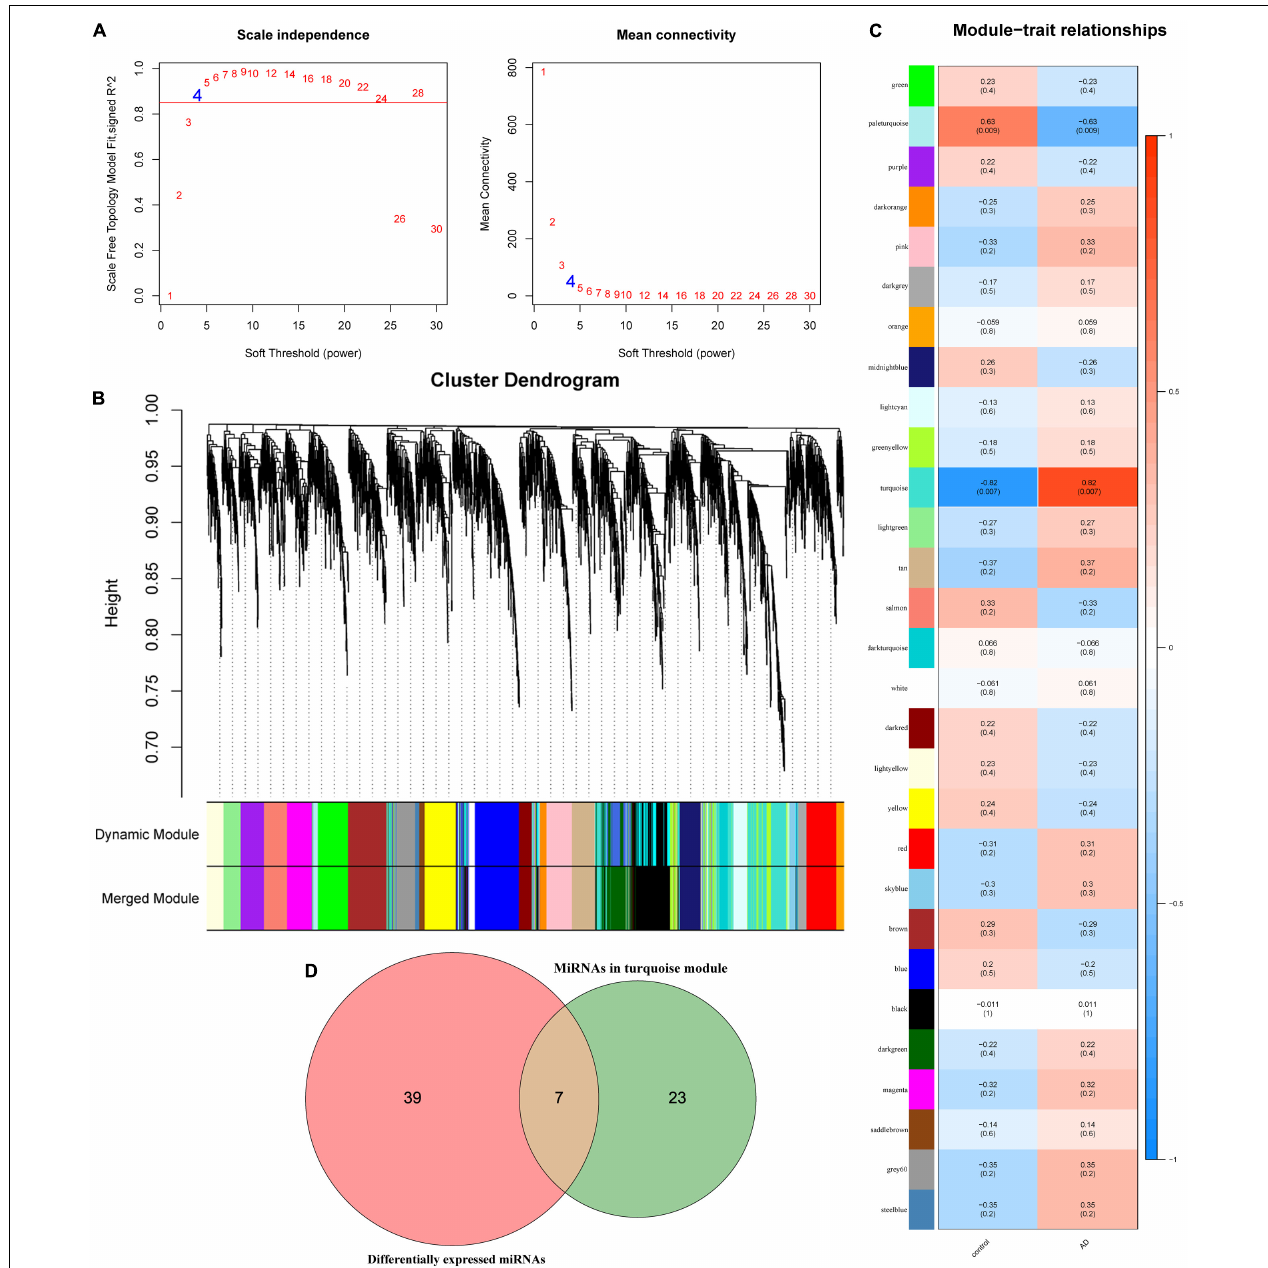
FIGURE 2 | Weighted gene co-expression network analysis analysis results in GSE157239 dataset. (A) Analysis of the scale-free index for various soft-threshold powers ( β ) and the mean connectivity for various soft-threshold powers. (B) Dendrogram of all miRNAs clustered in GSE157239. (C) Heatmap of the correlation between the module eigengenes and clinical traits of Alzheimer’s disease. (D) Venn diagram shows the overlapping miRNAs in the turquoise module and differentially expressed